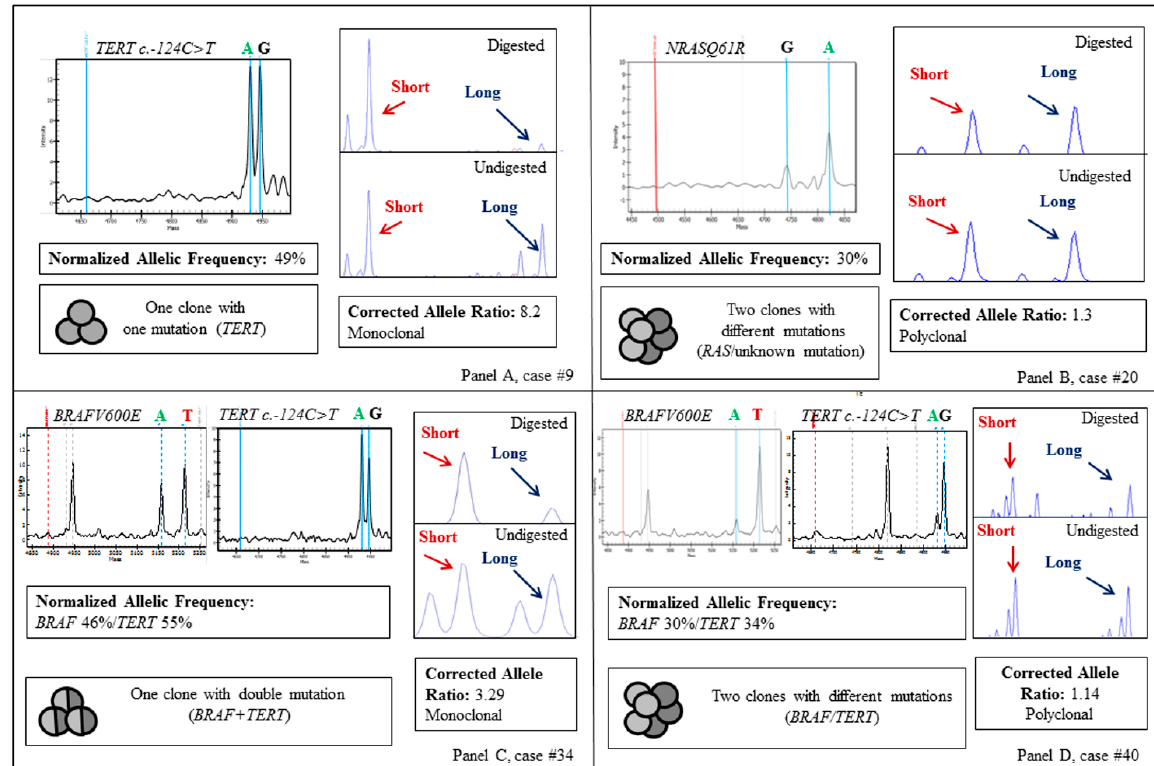
Figure 2. MassARRAY spectra and HUMARA assay electropherograms obtained in: one monoclonal case with single clonal mutation ( panel A ), one polyclonal case with single subclonal mutation ( panel B ), one monoclonal case with double clonal mutation ( panel C ) and one polyclonal case with double subclonal mutation ( panel D ). Panel D represents the most plausible scenario, considering that thyroid cancer is predicted to have a low mutational burden [27]. Nevertheless, the presence of two clones, one with double BRAF and TERT mutation and one with unknown mutation is also possible. TERT c.-124C>T mutation was detected by MassARRAY using a reverse primer.